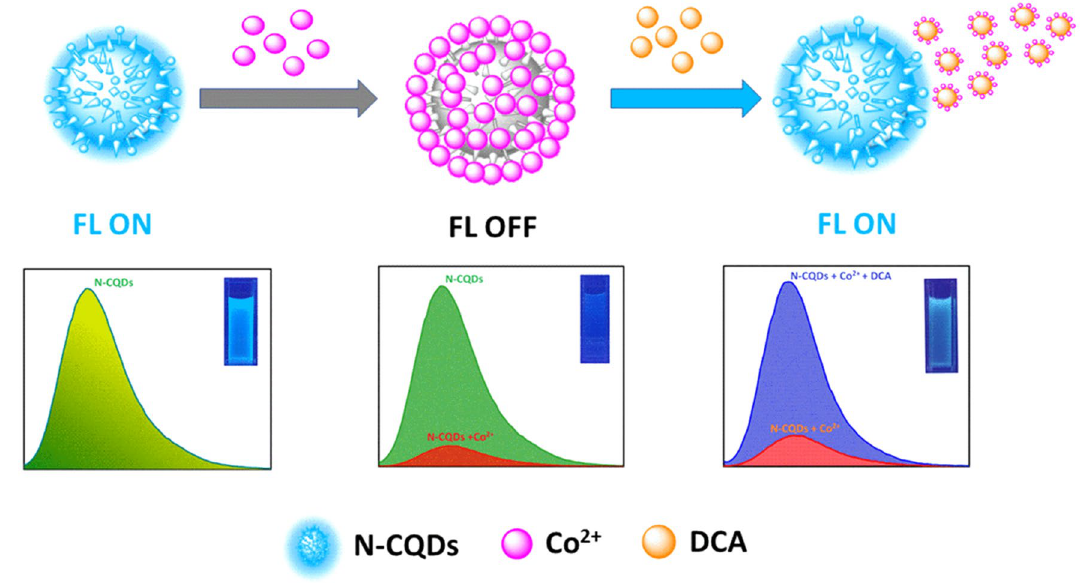
Figure 1. Schematic illustration of a switchable fluorescent N-CQDs for the detection of DCA based on aggregation and disaggregation